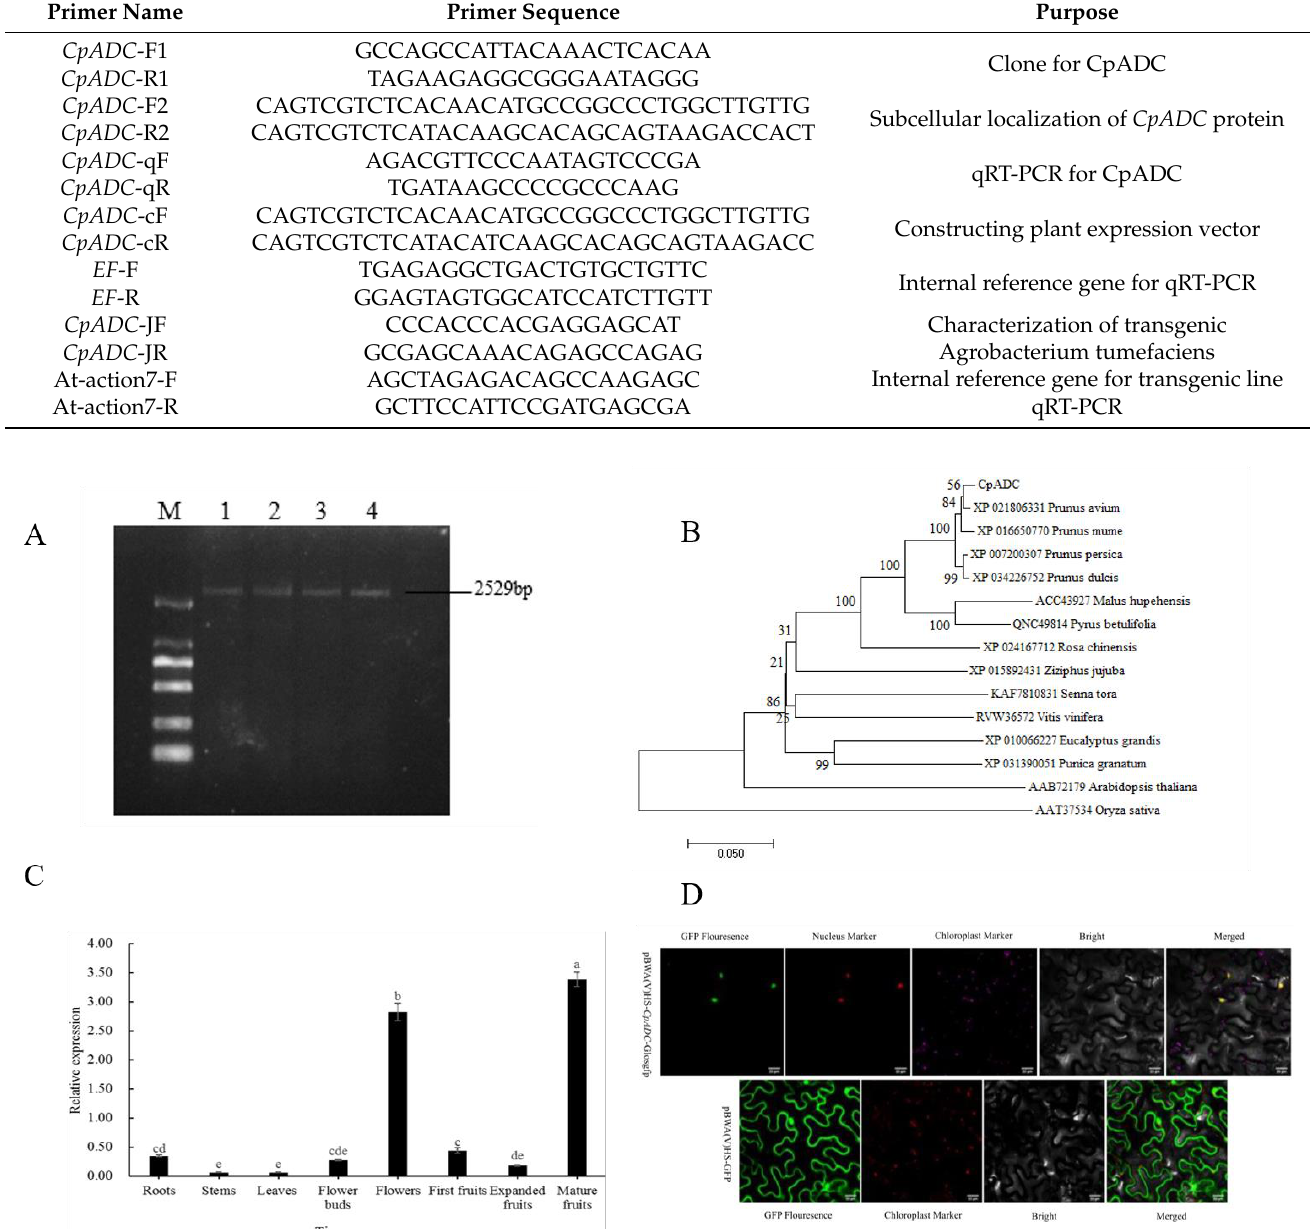
Figure 1. Obtaining of CpADC and its analysis. ( A ) Cloning of CpADC cDNA sequence from the leaves of cherry. Note: M: DL 2000 DNA marker; 1 – 4: CpADC Target fragment ( B ) Phylogenetic analysis of CpADC . ( C ) Tissue-specific expression of CpADC gene in cherry tissues by real-time quantitative PCR. Note: Different letters are used to indicate means that differ significantly ( p ≤ 0.05); the same blow ( D ). Subcellular localization analysis of CpADC , which is localized in the nucleus in N. benthamian Tobacco leaves. Note: Respectively, from left to right: GFP fluorescence (green), nucleus fluorescence (red), merged images (green and red) and bright-field chloroplast images are shown. Scale bars = 10 µ